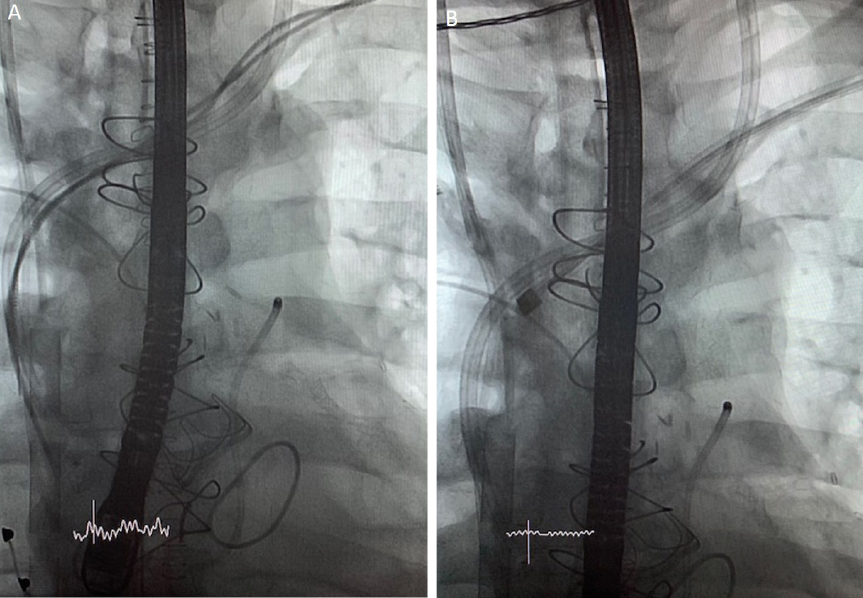
distally cut during an open surgical procedure and venous ECMO cannula ending in the right atrium. (B) Laser lead extraction procedure with RV lead in laser